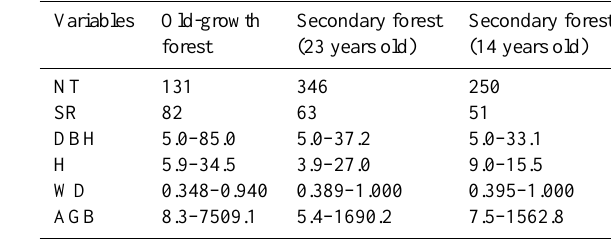
Table 1. Summary of the data set applied in this study. Trees were harvested in the Estação Experimental de Silvicultura Tropical, a contiguous terra firme forest reserve near Manaus,